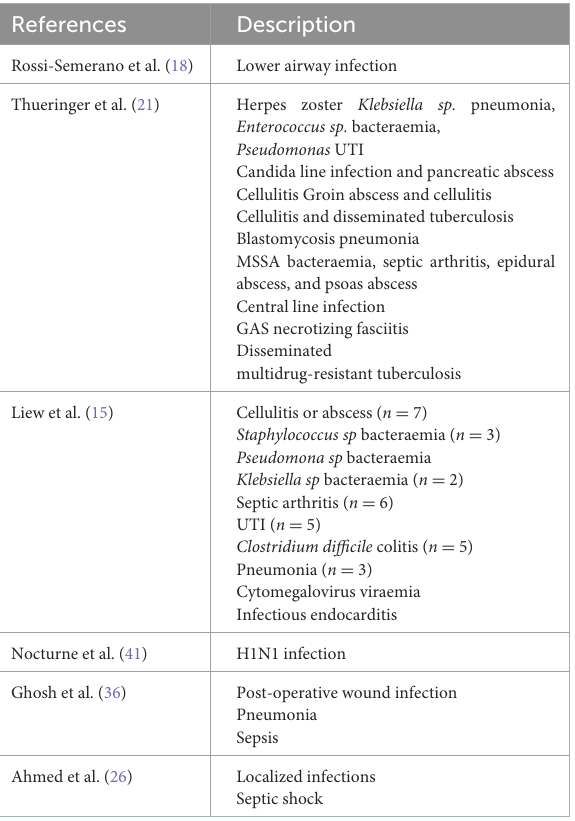
TABLE 3 Active infections at initiation of anakinra, including our case